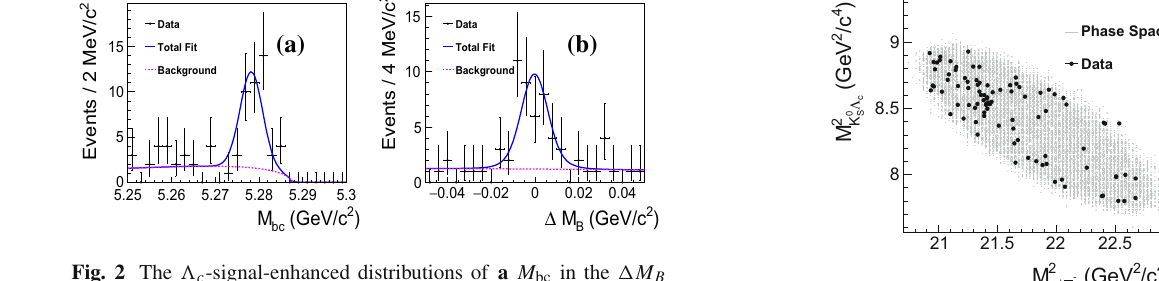
¯ (cid:4) − (cid:4) + c c , S Fig. 3 Dalitz distribution of reconstructed ¯ B 0 → K 0 dates in the B signal region. The black dots are data; the shaded region is the MC simulated phase-space distribution